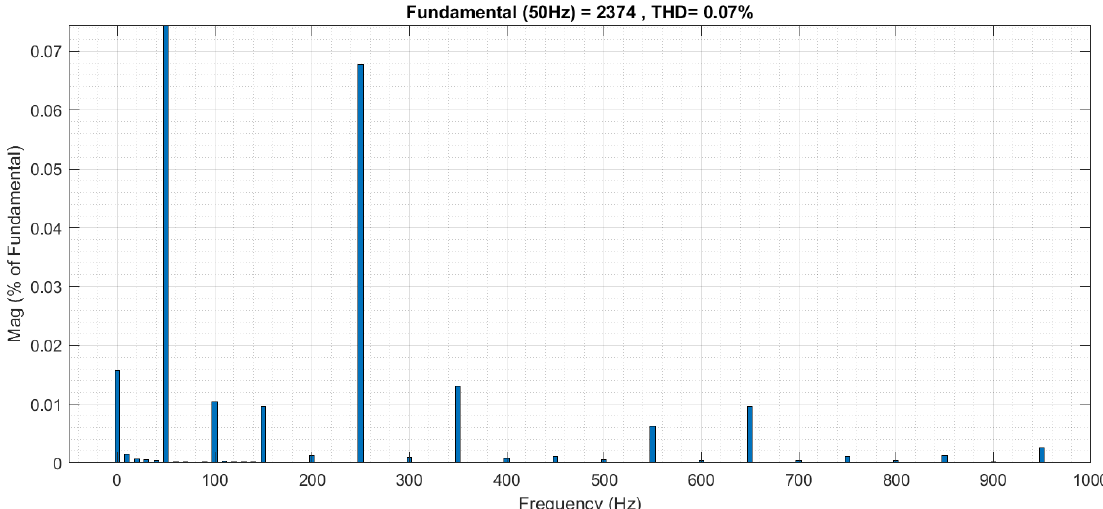
Figure 6. Harmonics in utility grid when operated with all chargers and harmonic filters.